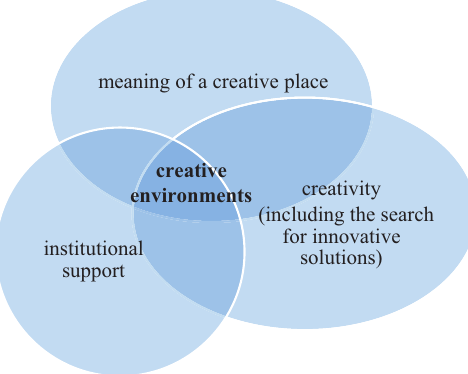
Figure 1. Meaning of a creative place, category of creativity (including the search for innovative solutions), and institutional support for forming the foundations of creative environments (source: created by authors on the basis of Florida’s analyses (2004, 2010))